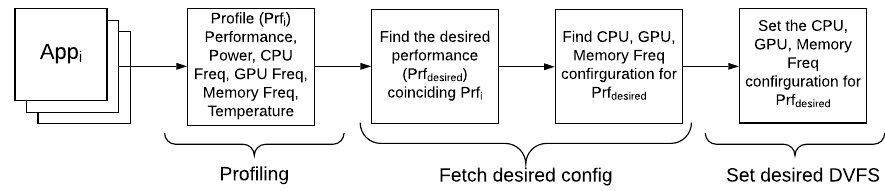
Figure 3. Block diagram illustrating the CGM-DVFS